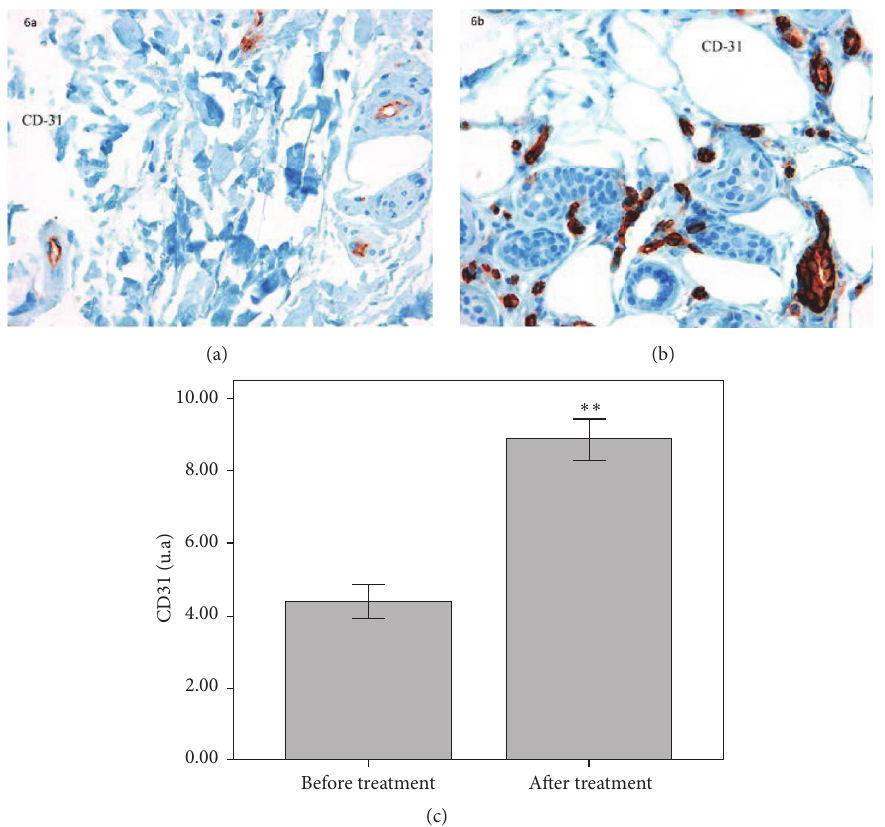
Figure 6: Immunohistochemical staining of the endothelial marker CD-31 before (a) and after treatment (b) showing the increase in vascular presence after cosmetic treatment (40x magnification). Quantification of CD31 positive cells showed a 102.3% increase after treatment compared to baseline ( ∗∗ 𝑝 ≤ 0.01 ) (c).